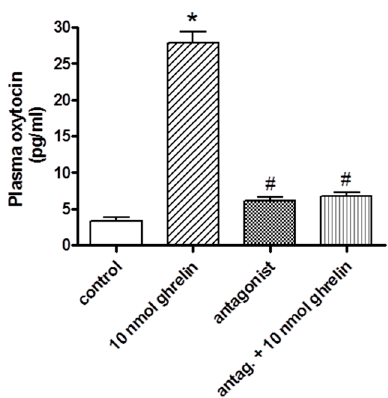
Figure 4. Effects of systemically (i.v.) administered ghrelin antagonist on the plasma oxytocin level (expressed as pg/mL). Results shown as means ± S.E.M., n = 10. Statistical significance: * p < 0.05 relative to the control group and # p < 0.05 relative to the 10 pmol ghrelin-treated group .